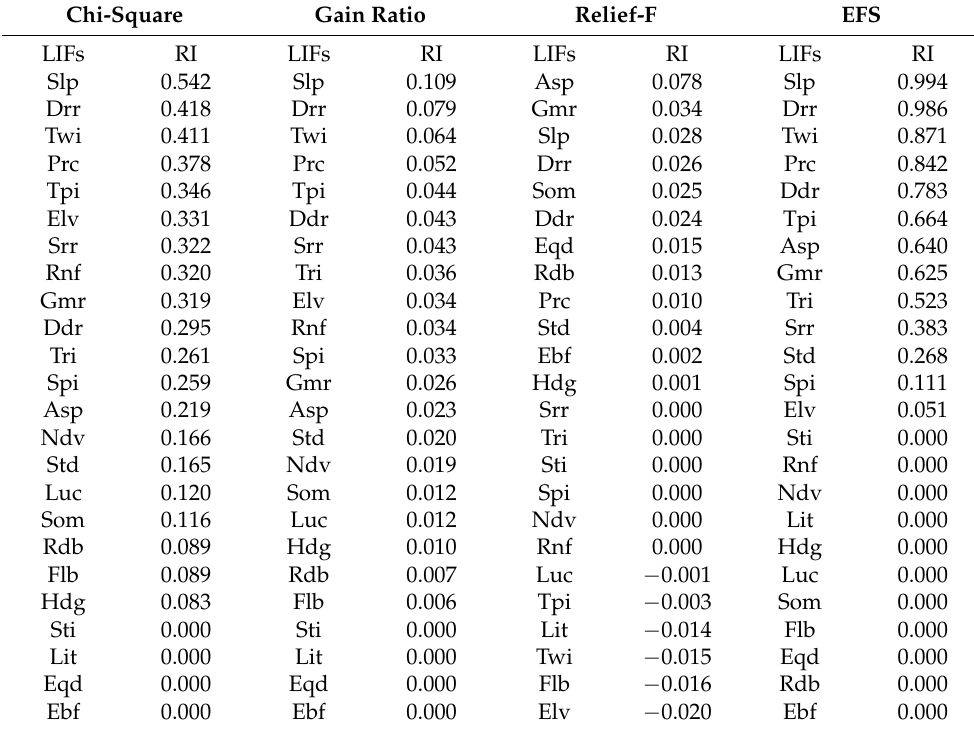
Table 4. Relative importance (RI) of different LIFs derived from FS and EFS methods. LIFs are sorted in descending order based on their RI. The abbreviation of LIFs is provided in Table